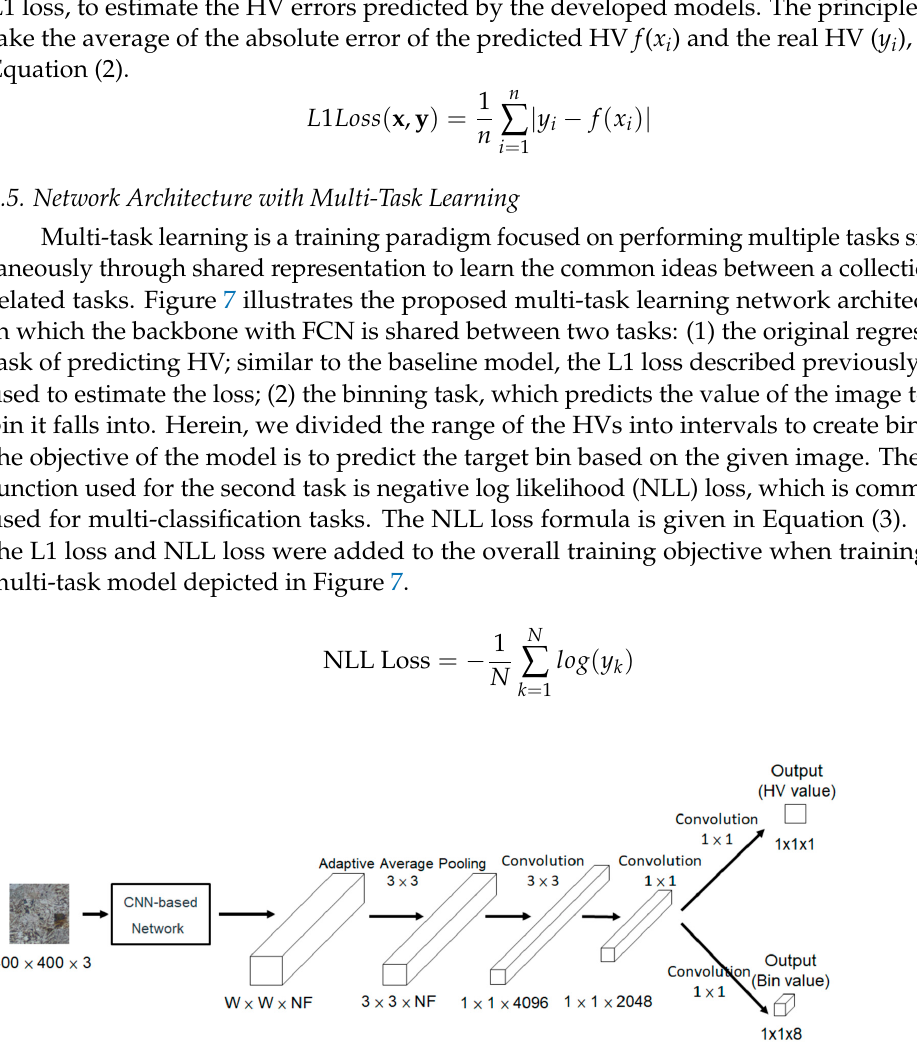
Figure 7. The proposed multitask model architecture for prediction of HVs. Here, NF refers to the number of filters of the CNN